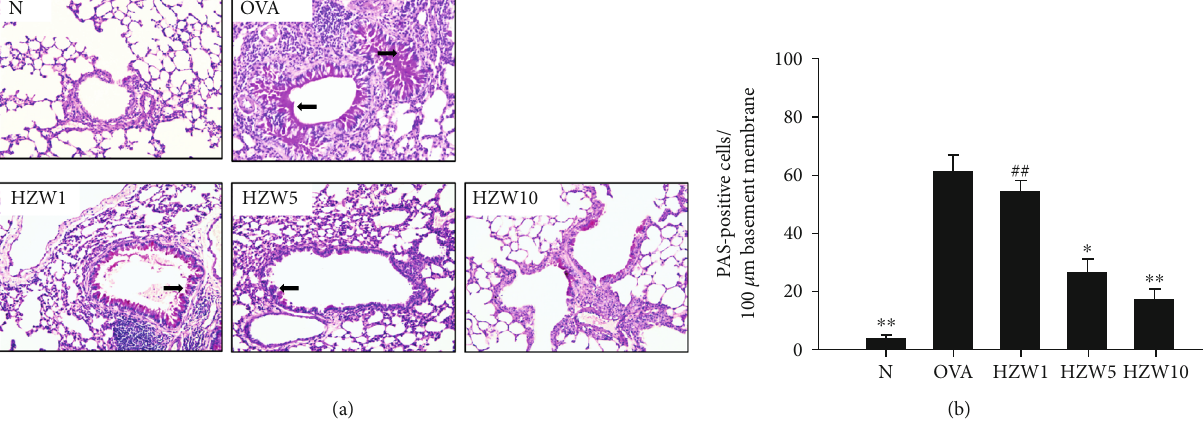
Figure 7: The e ff ects of HZW on goblet cell hyperplasia in the lung tissue of OVA-sensitized mice. (a) Lung sections (6 μ m) were stained with PAS to observe goblet cell hyperplasia (200x magni fi cation). Goblet cells were indicated with arrows. (b) Results expressed as the number of PAS-positive cells per 100 μ m of the basement membrane. Data are presented as the mean ± SEM . ∗ P < 0 : 05 and ∗∗ P < 0 : 01 compared with the OVA control group. ## P < 0 : 01 compared to the HZW10